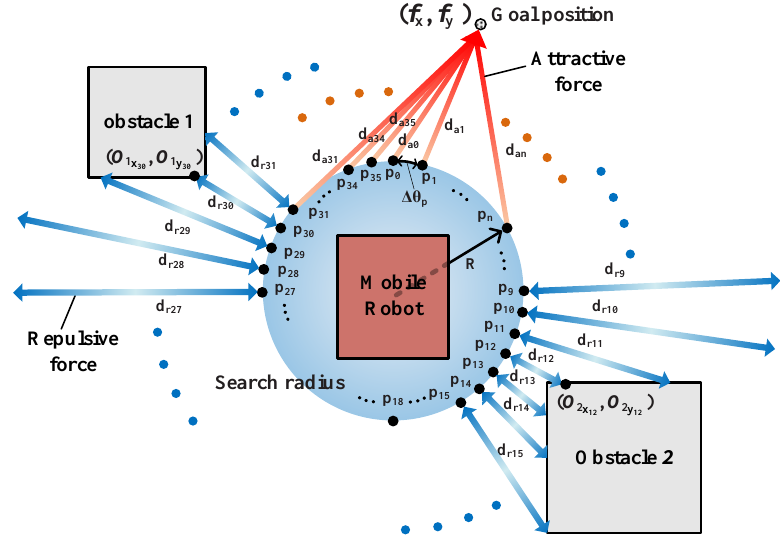
Figure 8. Sensor system of the potential field navigation system (search radius).